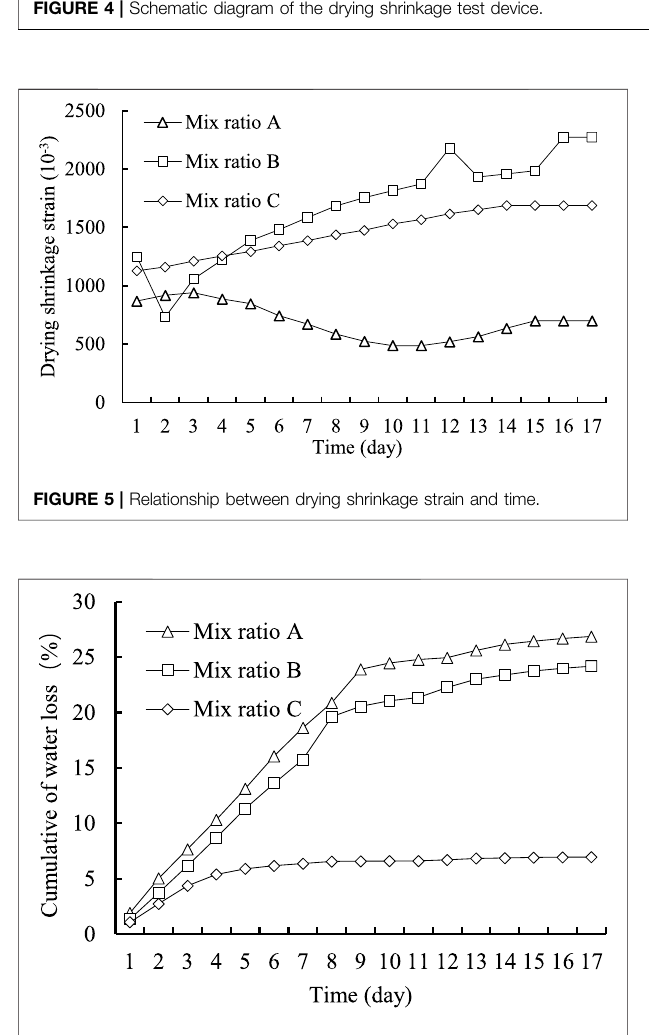
FIGURE 6 | Relationship between the cumulative rate of water loss and time.